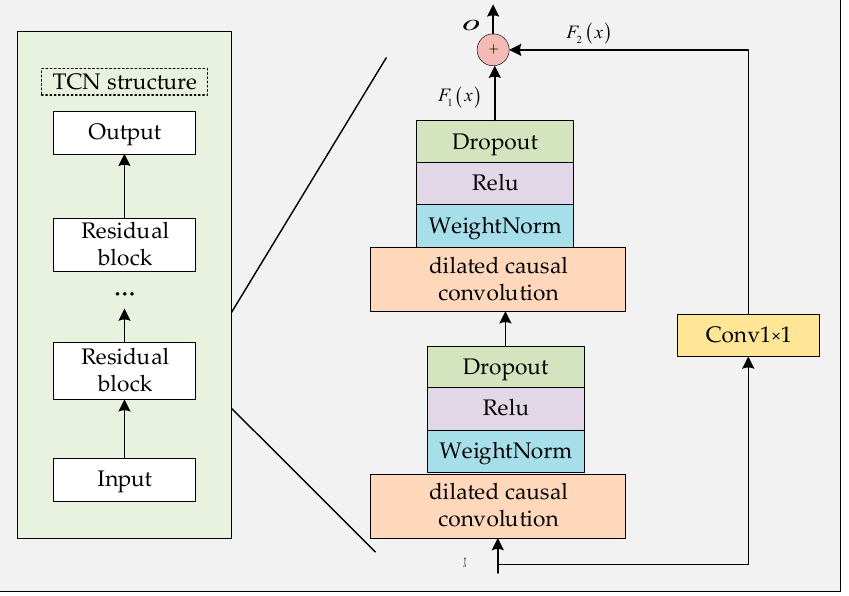
Figure 5. Residual blocks.